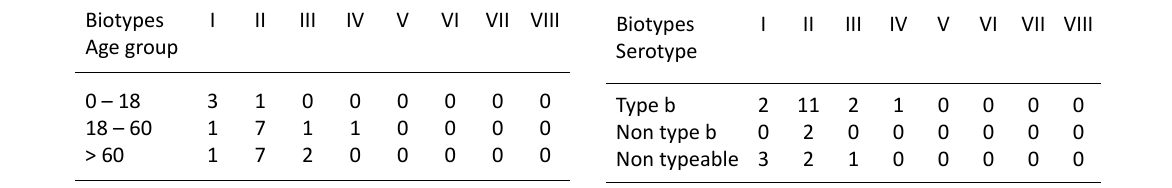
Table 3. Biotype distribution of H. influenzae by age Biotypes